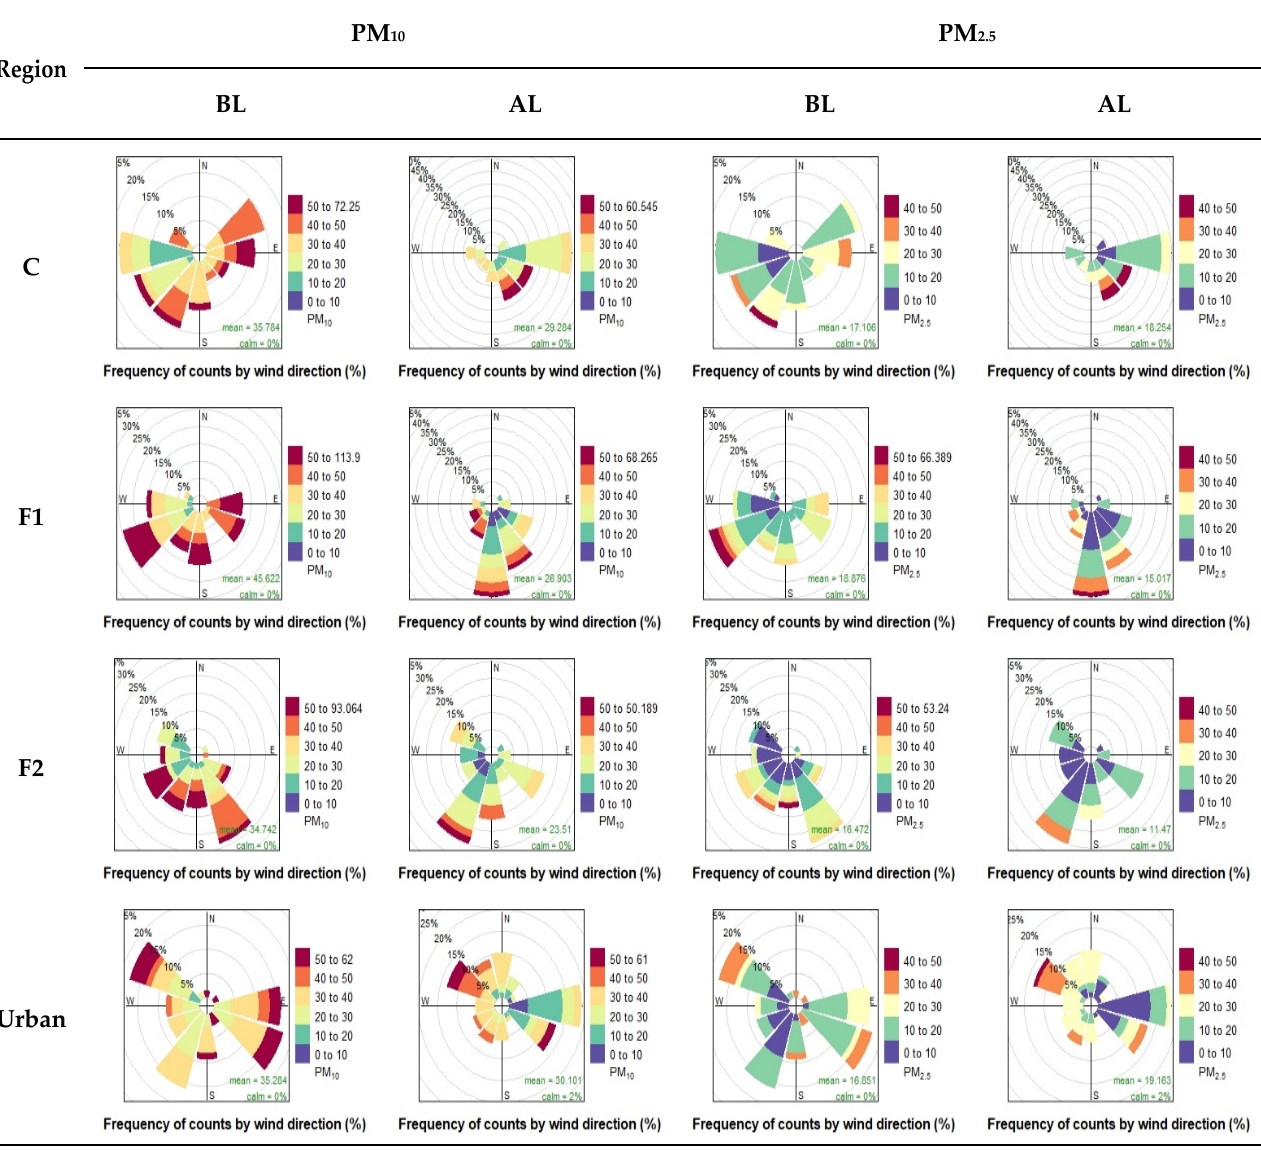
Figure 4. Seasonal changes in pollution roses of PM 10 and PM 2.5 in Yeouido Saetgang Ecological Park. BL: Before leaf development (March–April), AL: After leaf development (May–September), WD: Wind direction, WS: Wind speed. Table 3. Average of PM 10 , PM 2.5 , WD, and WS as seasonal changes in Yeouido Saetgang Ecological Park.